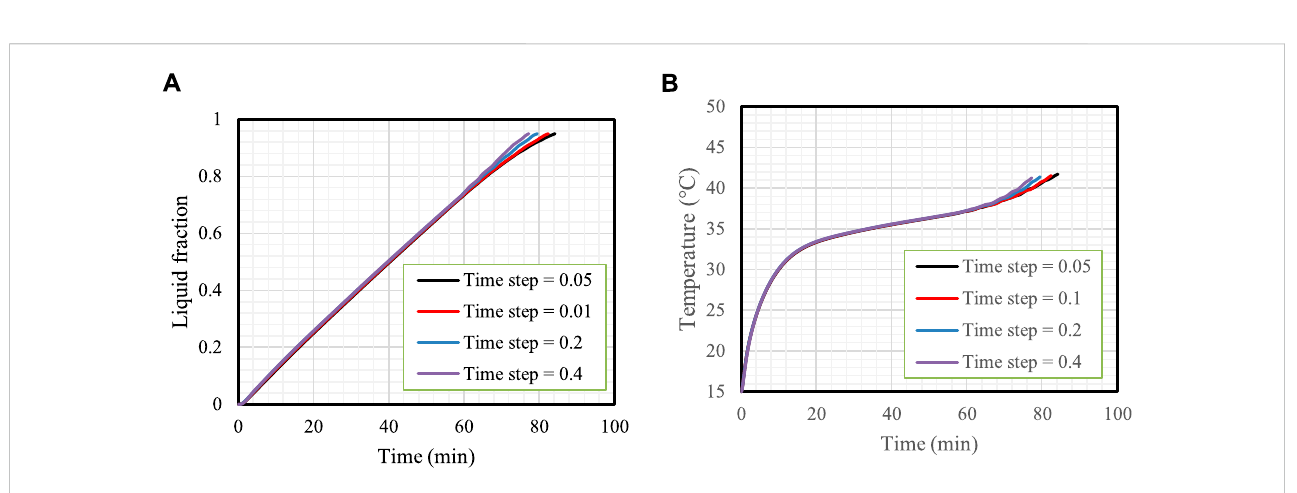
FIGURE 3 Time step size analysis. Variation in the liquid fraction (A) and mean temperature (B) for different time step